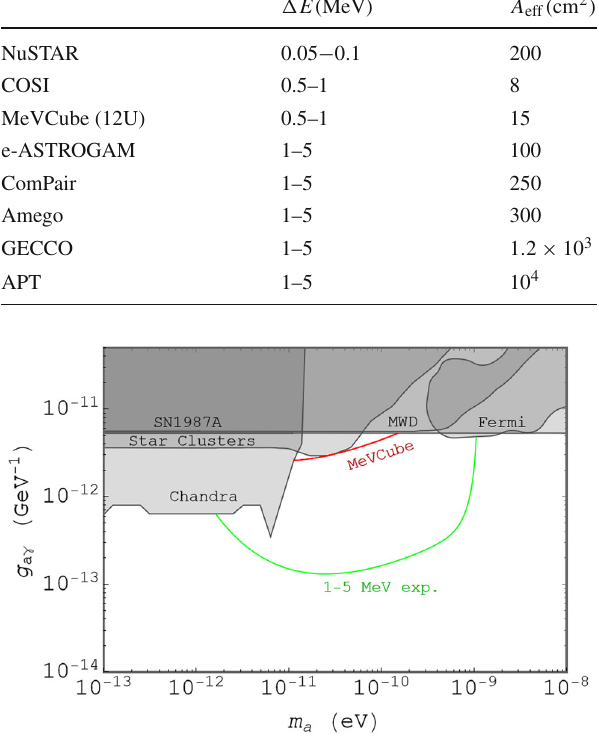
Fig. 2 Region of the parameter space giving more than 1 event in MeVCube 12U (red line) from ν BADM converting into photons. For experiments in the 1–5 MeV energy bin, we show the region with a SNR larger than 2 (green line). Here, we have considered a SN at d SN = 0 . 197 kpc, g ν a = 3 GeV − 1 and m ν = 50 meV.